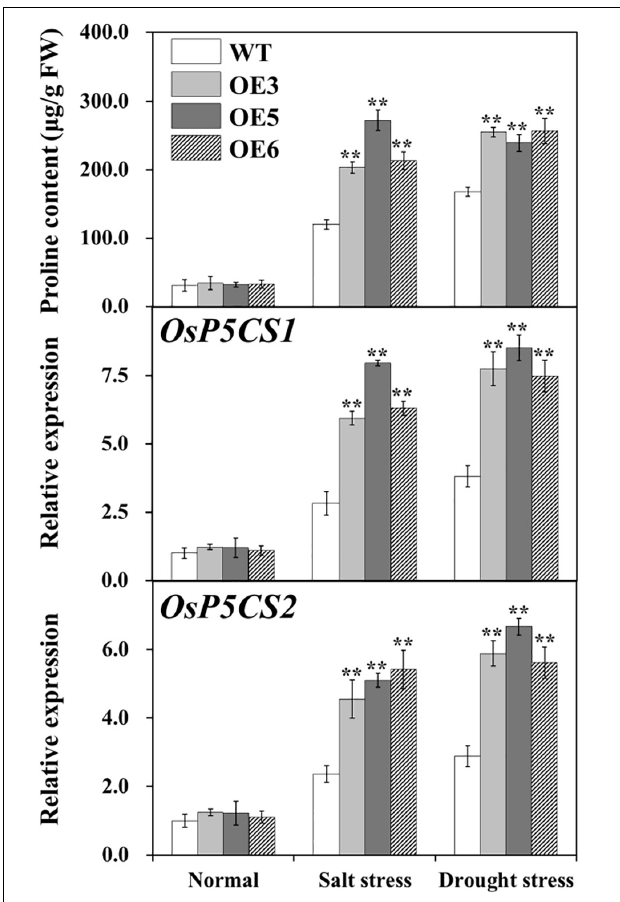
FIGURE 7 | Free proline content and the expression of proline biosynthesis genes in the leaves of overexpressing OsIAA18 and WT plants under salt and drought stresses. Data are presented as means ± SE ( n = 3). The values for * and ** indicate a significant difference from that of WT at P < 0.05 and < 0.01, respectively, by Student’s t